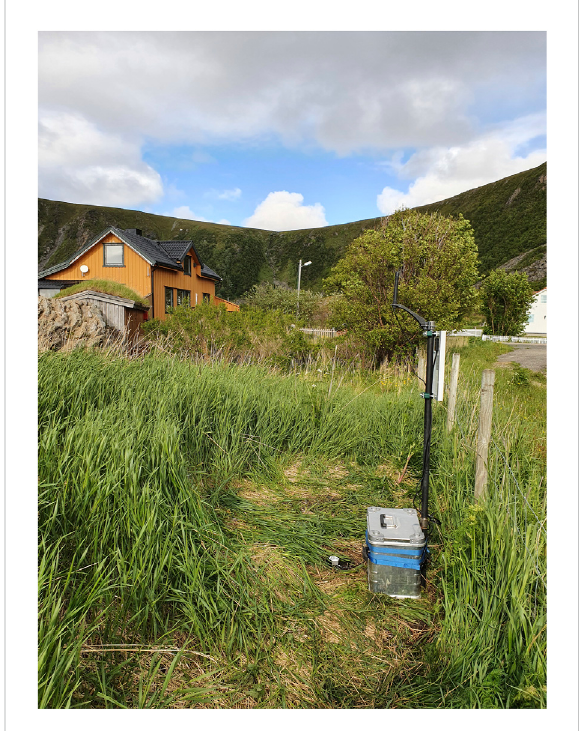
FIGURE 7 Environmental monitoring station installed at the